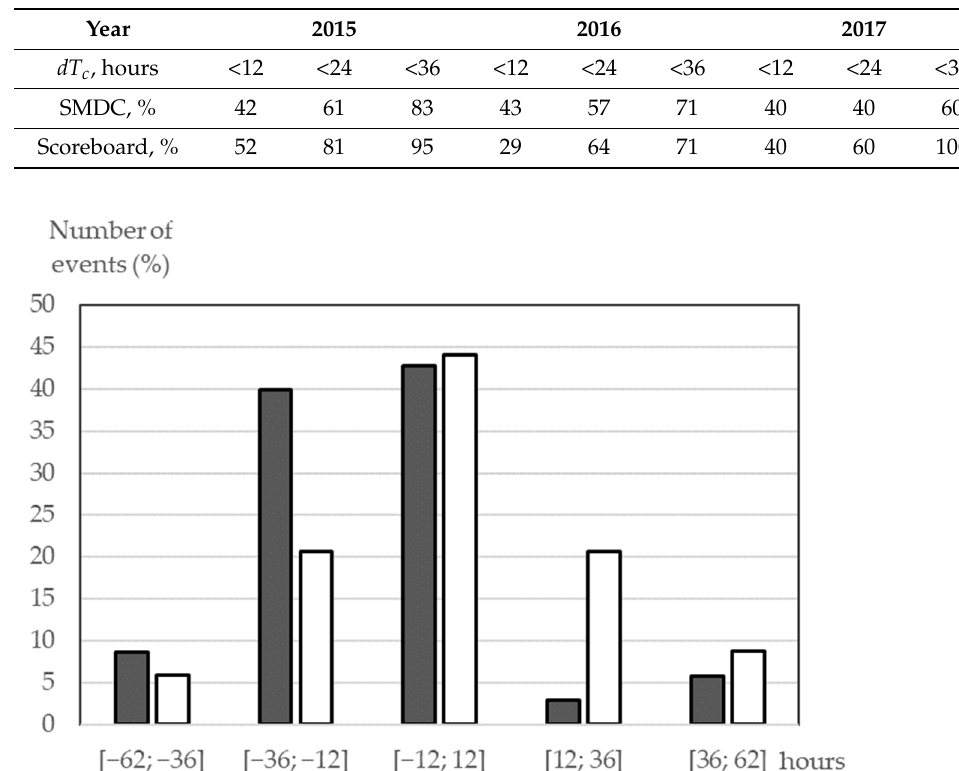
Table 3. Probabilities of the ICME forecast (in % of the observed hit events to all predictions) within the confidence intervals dT c of the arrival time for 2015–2017 obtained by the basic SMDC and published by CCMC Scoreboard “Average of methods”.